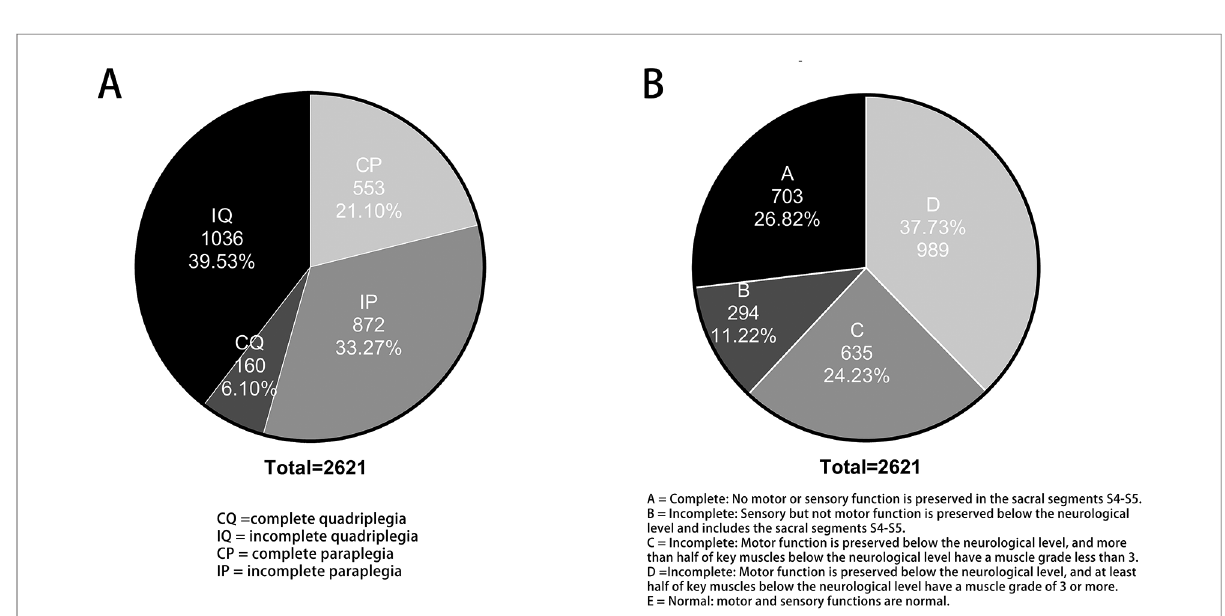
FIGURE 3 Distribution of fracture level for TSCI patients by the type of fracture ( n =2621).